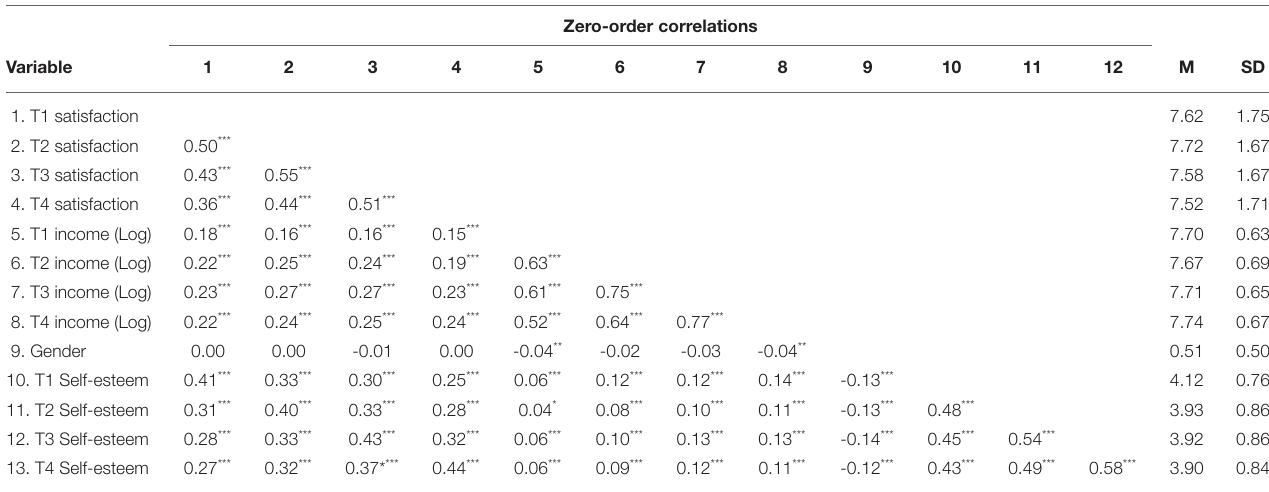
TABLE 1 | Zero-ordecorrelations and descriptive